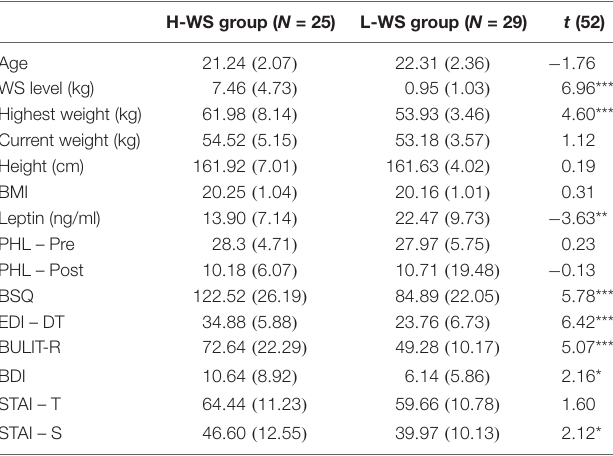
TABLE 1 | Mean (SD) of demographics, body and eating-related characteristics of the high and low levels of weight suppression